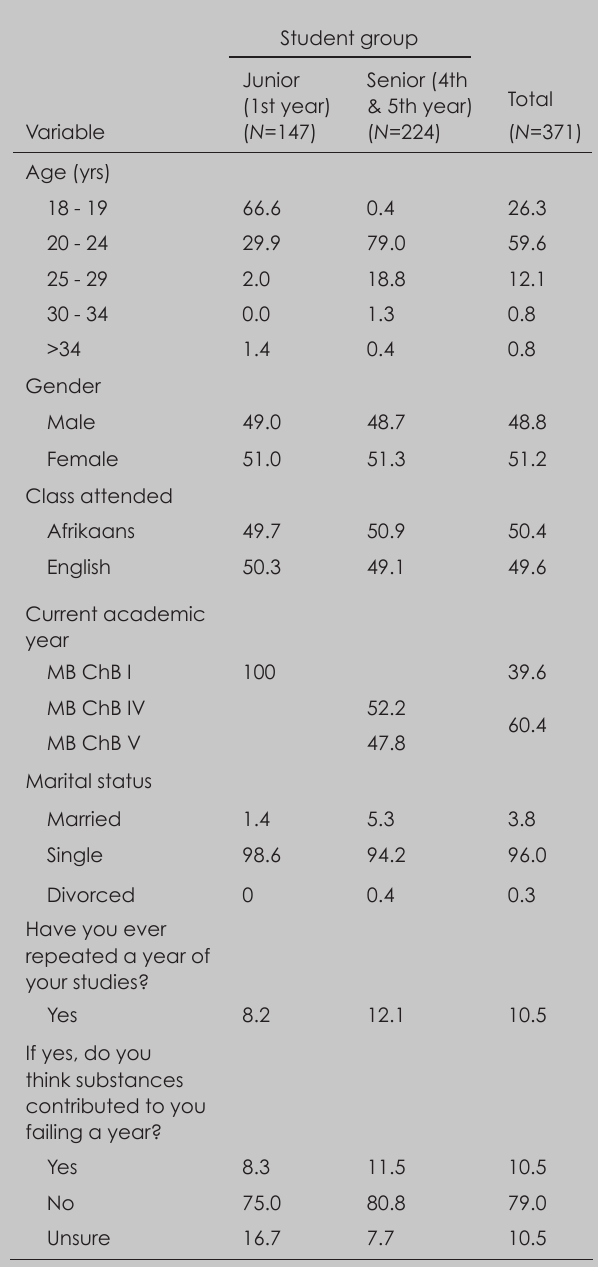
Table I. Demographic data of respondents